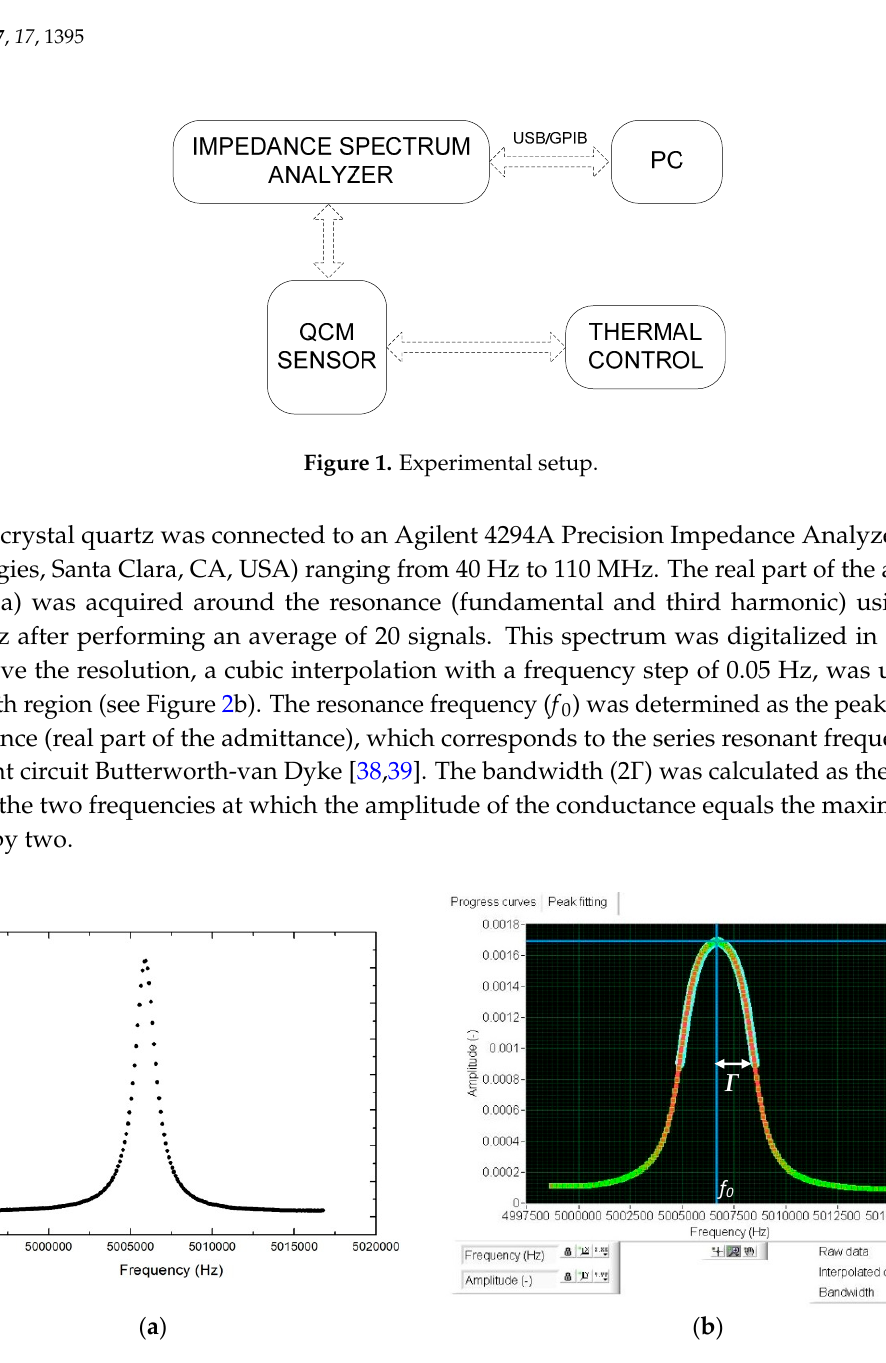
Figure 2. Example of acquisition of the real part of the admittance for the fundamental frequency of 5 MHz ( a , b ) the calculation of the values of the resonant frequency and the bandwidth using interpolation.